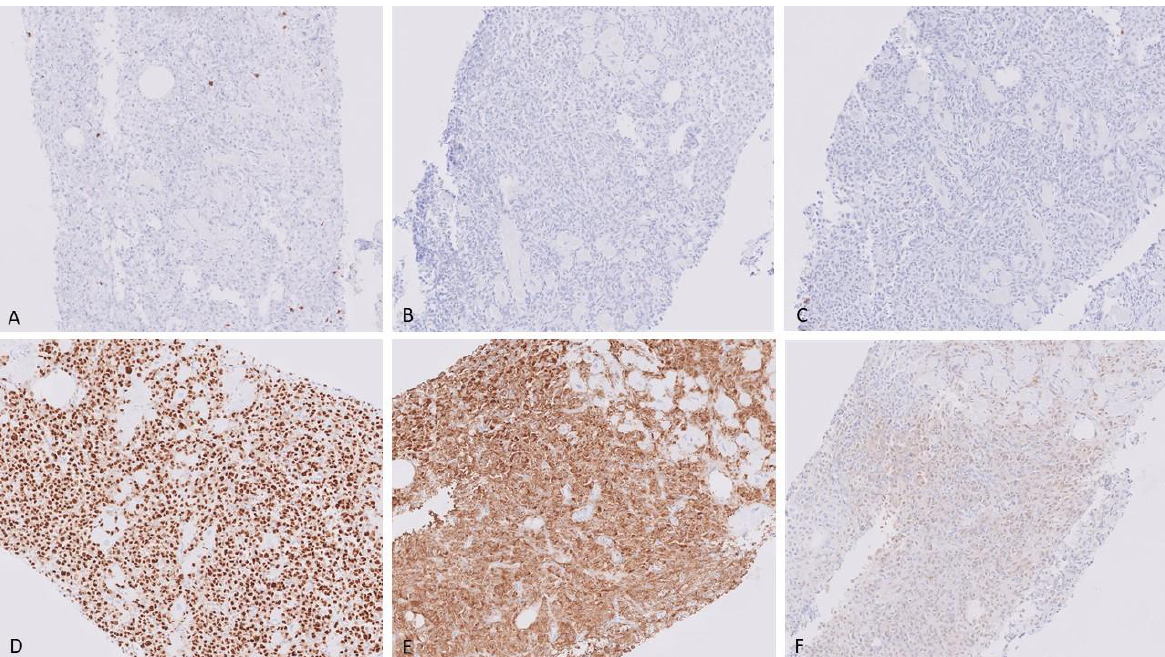
Figure 5. Immunohistochemical stains, showing neoplastic cells negative for CD3 ( A ) X40, CD20 ( B ) X40), and CD138 ( C ) X40. They are positive for MUM1 ( D ) X40, and lambda ( E ) X40. Negative for kappa ( F ) X40.